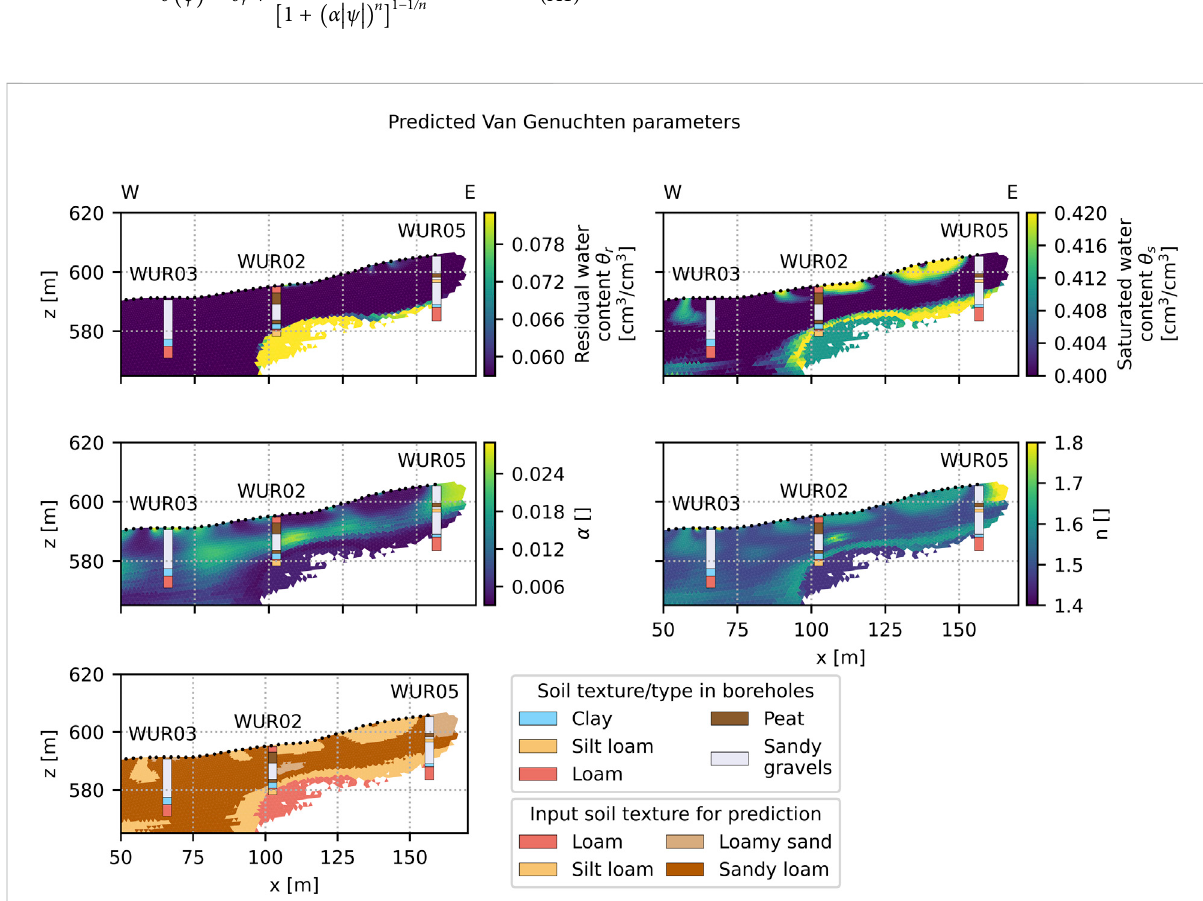
FIGURE A1 Van Genuchten water retention parameters for the pro fi le WD13 as predicted with Rosetta (Zhang and Schaap, 2017) using the soil texture presented in the bottom subplot. Each subplot further contains the soil texture observed in the boreholes WUR02, WUR03 and